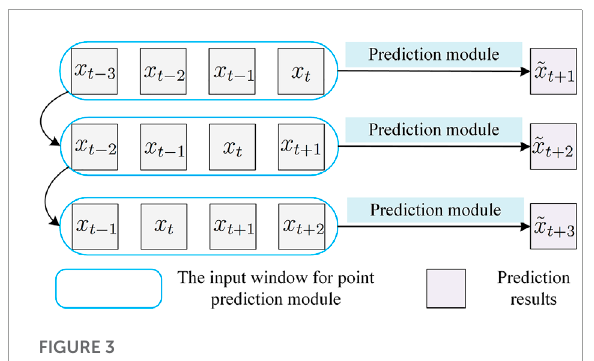
FIGURE 3 PV power forecasting based on point prediction